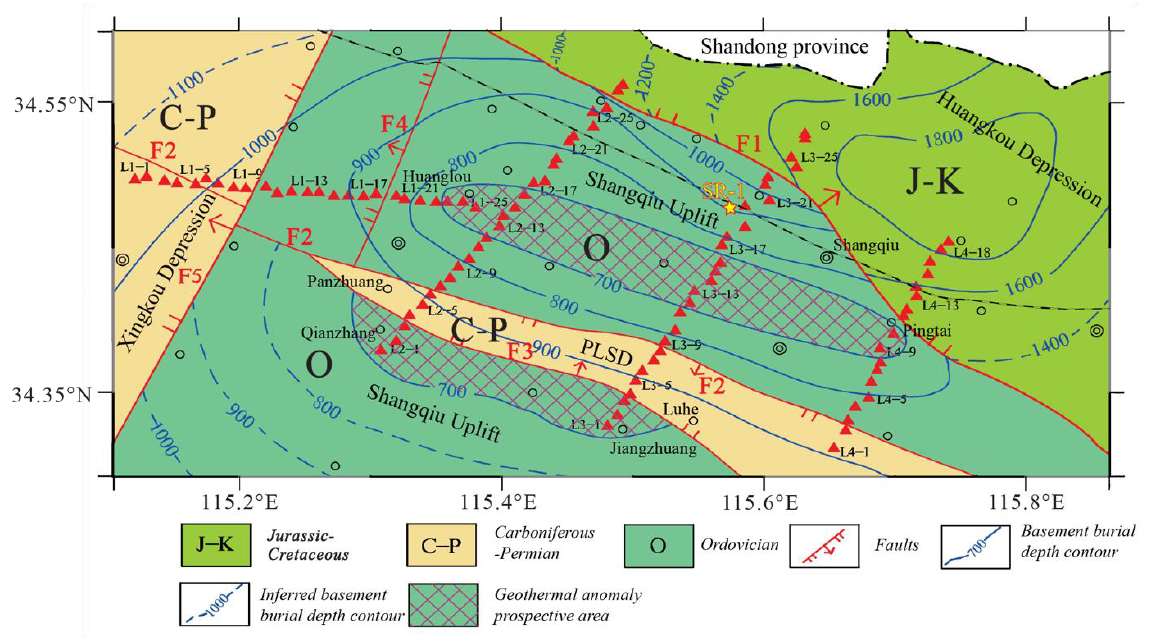
Figure 8. The basement-rock burial depth contour inferred with the resistivity models and the proposed prospective geothermal anomaly areas. PLSD: Panzhuang-Luhe Secondary Depression. F1: Jiaozuo-Shangqiu fault, F2: South Shangqiu fault, F3: Luhe fault, F4: Ningling fault, and F5: Suixian fault. Yellow star labelled with “SR-1” represents the location of the well.